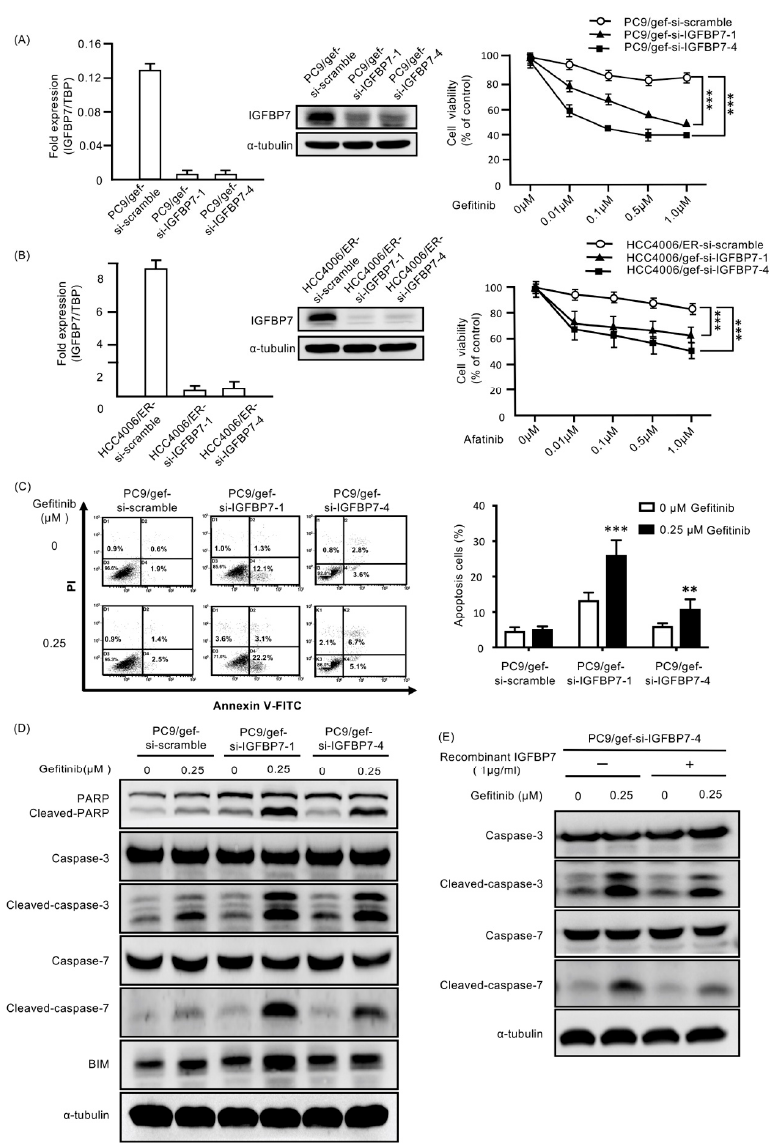
Figure 3. Knockdown of IGFBP7 expression reversed EGFR-TKI resistance in PC9/gef, HCC4006/ER, and HCC827/gef cells by enhancing EGFR-TKI-induced caspase activity and BIM expression ( A ) PC9/gef cells and ( B ) HCC4006/ER cells were transfected with IGFBP7 small interfering RNAs (siRNAs; si-IGFBP7-1 and si-IGFBP7-4) or scramble siRNA (si-scramble). The effect of siRNAs was evaluated by quantitative RT-PCR and Western blot analysis (left). Cellular viability of si-scramble and si-IGFBP7 transfectants was determined following treatment with various doses of gefitinib for 96 h in MTS assays (right). Error bars show the standard deviations for n = 3 independent experiments (*** p < 0.001). ( C ) The percentage of apoptotic cells was quantified after treatment with gefitinib (0.25 µ M). The columns are the means of three independent experiments. Error bars show the standard deviations (** p < 0.01; *** p < 0.001). ( D ) PC9/gef was exposed to 0.25 µ M of gefitinib for 24 h. Next, apoptosis markers, including cleaved poly-(ADP-ribose) polymerase (PARP), caspase-3,